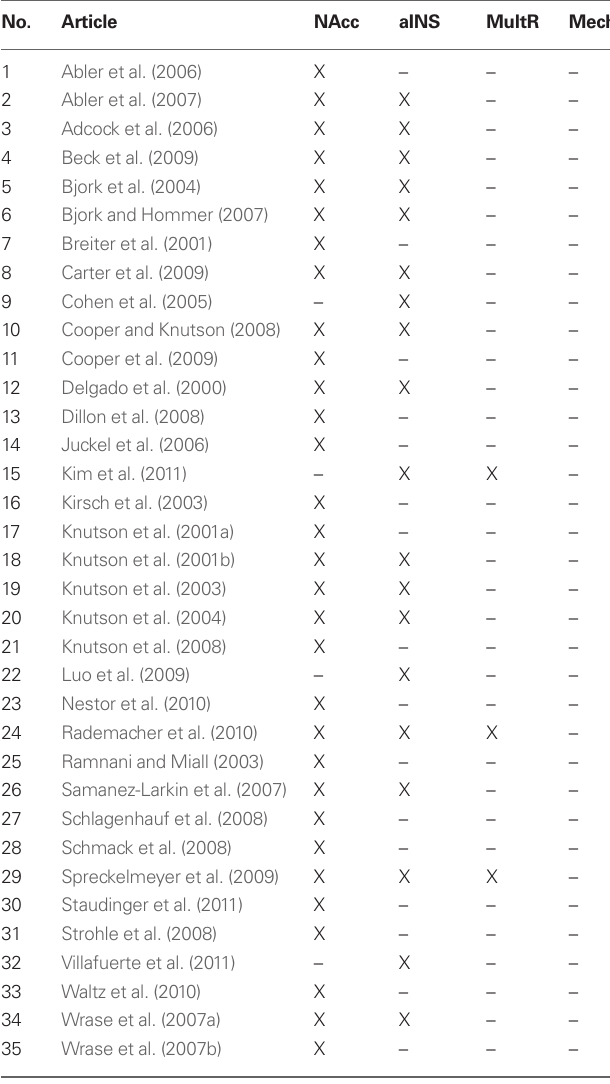
Table A1 | Literature search for imaging studies of reward